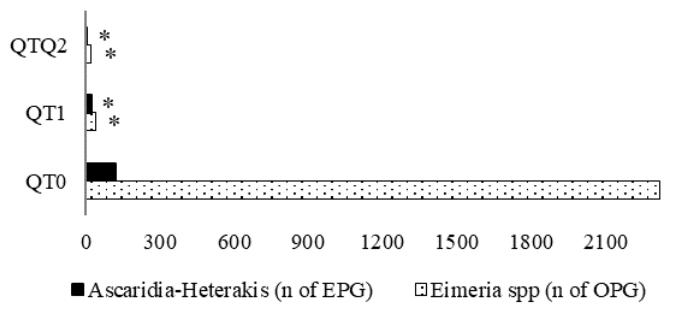
Figure 5. Ascaridia-Heterakis (A-H) and Eimeria spp. load in fecal samples from 174-day-old birds. * Indicates a difference between treatment and QT0 (Dunnett’s t -test, p < 0.05). QT0 = basal diet; QT1 and QT2 = the basal diet supplemented with QT at 1% and 2%, respectively. EPG = eggs per gram; OPG = oocytes per gram.